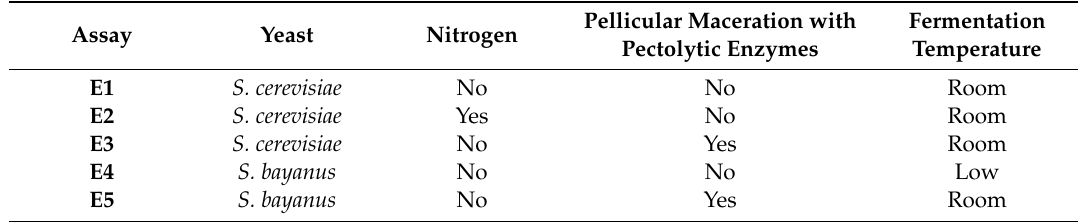
Table 1. Experimental conditions of the 5 fermentation assays carried out with Muscat must extracted from grapes dried in a climatic chamber in vintage